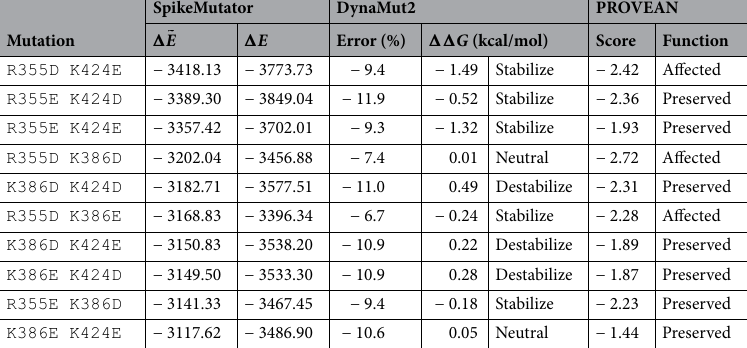
Table 4. Prediction scores of top stabilizing 2-point mutations in the receptor-binding domain.